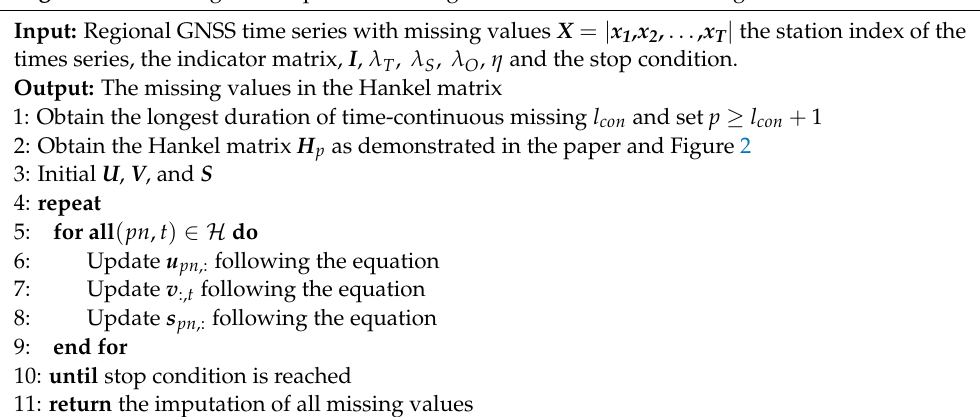
Algorithm 1 Missing data imputation for regional GNSS time series using